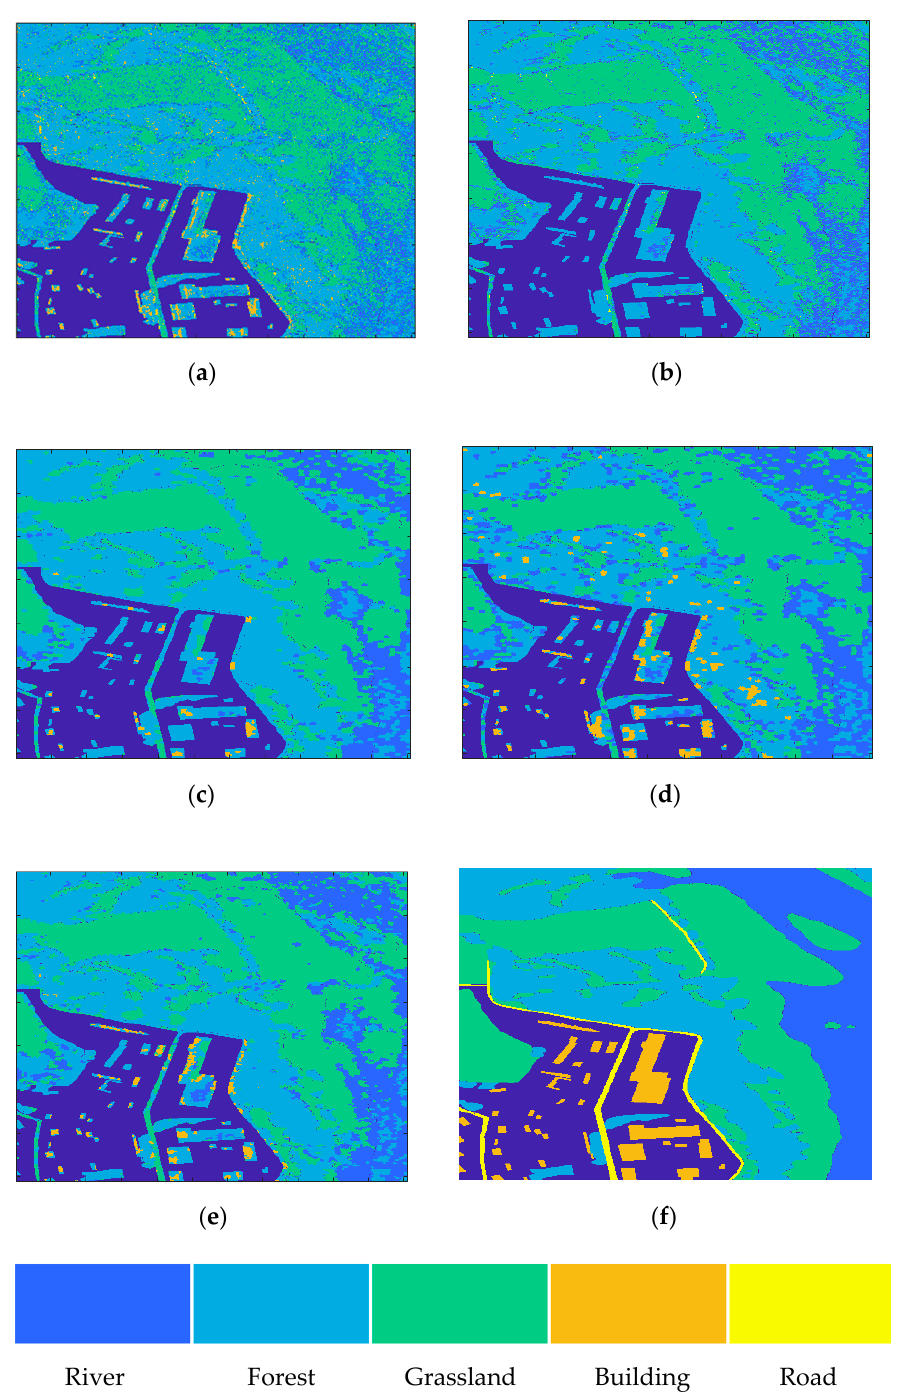
Figure 8. The classification results on the Lillestroem image. ( a ) CNN. ( b ) CNN-MRF. ( c ) CNN-SP. ( d ) RCC-MRF. ( e ) Proposed method. ( f ) Ground truth. ( d ) RCC-MRF. ( e ) Proposed method. ( f ) Ground